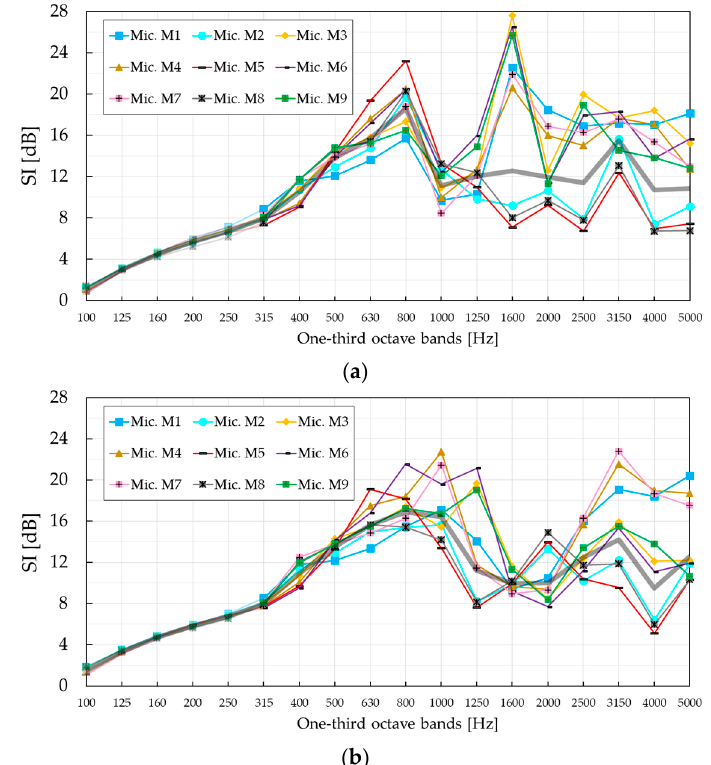
Figure 10. SI values measured at individual microphone positions M1–M9. Thick black curve shows the averaged SI values over all nine microphones. ( a ) Sound insulation index SI , configuration A; ( b ) sound insulation index SI , configuration B .